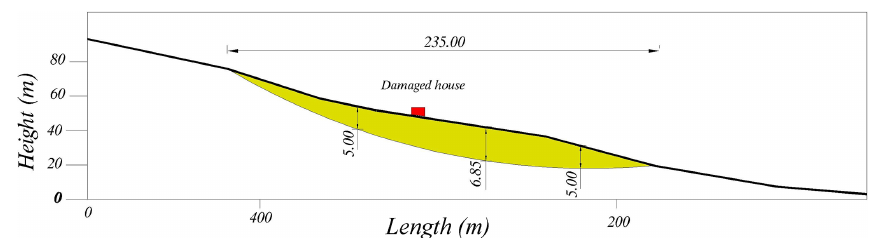
Figure 9. Characterization and longitudinal section of the rotational sliding (Geolen Engineering, 2010). The location of the dragged house is noted in red, which was analysed by the TS model.